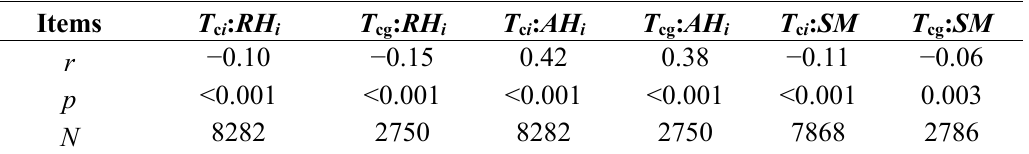
Table 10. Correlation coefficient in FR mode.